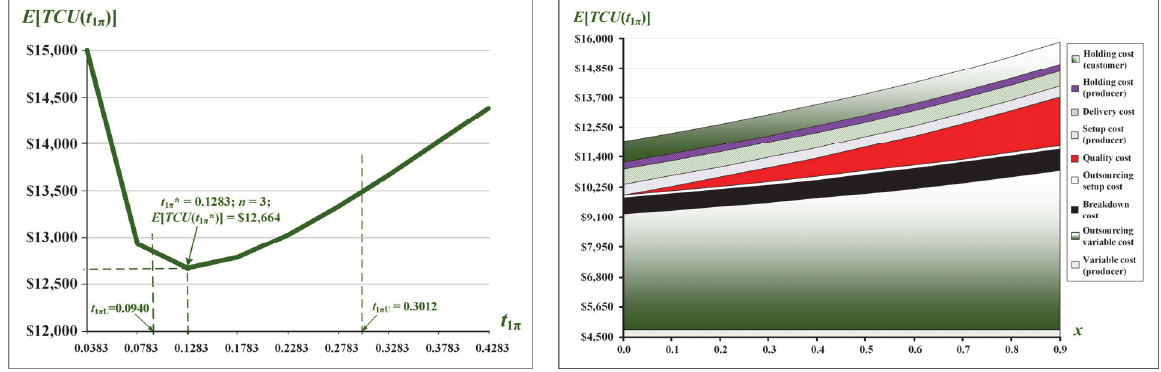
Fig. 9. Variations in random scrap rate x effect on different system cost